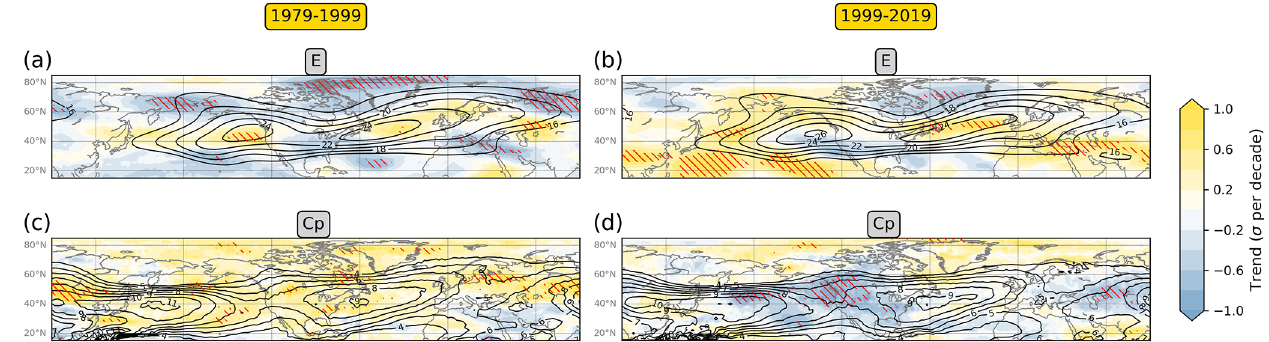
Figure 10. Maps of 1979–1999 linear trends (Theil–Sen estimator; colour shading) in the standardized seasonal-mean (a) E and (c) c p at 300hPa for DJF in ERA5. (b, d) Same as panels (a) and (c) , but for 1999–2019. Red hatching indicates areas where the trend monotonicity is statistically significant at the 0.10 significance level. Black contours correspond to the multiyear mean fields of the respective period. Masked grid points are indicated by grey shading.